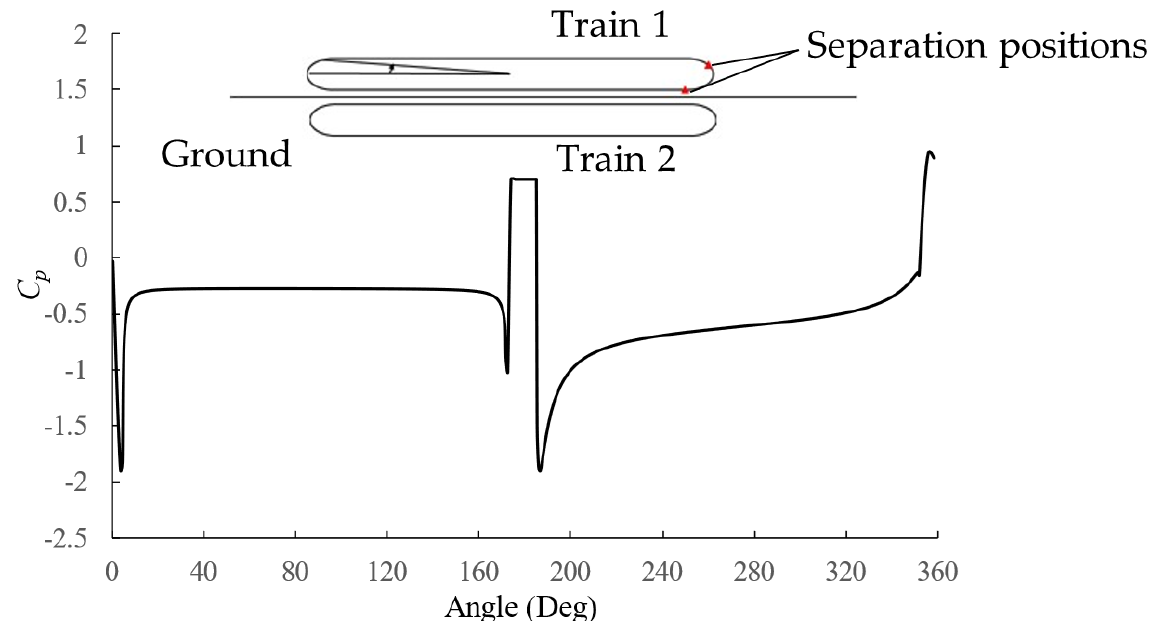
Figure 12. Pressure distribution on the train with the ground configuration.